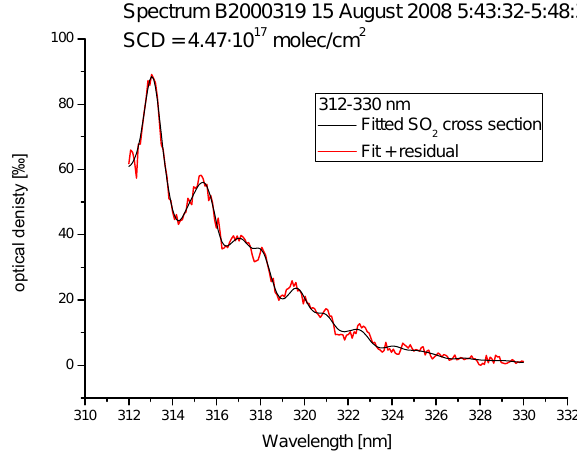
Fig. 2. Example fit for SO 2 , (sum of 10 spectra) recorded between 05:43:32 and 05:48:37UTC while flying over the Kasatochi plume.